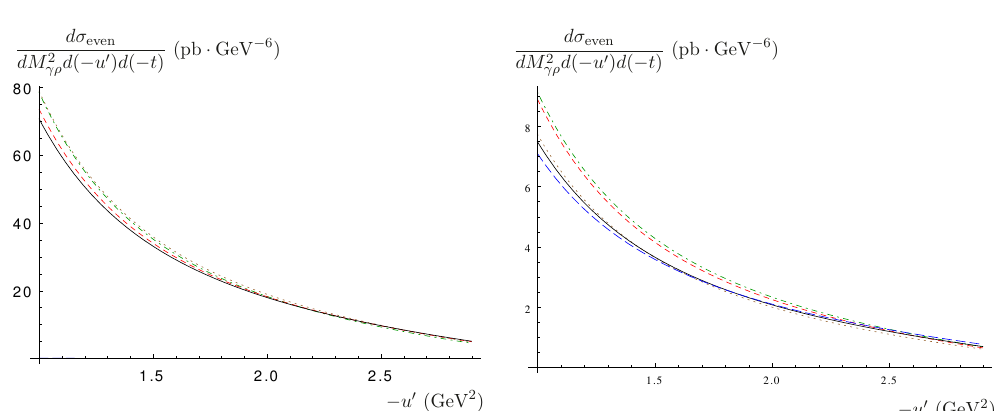
= 4 GeV 2 . The various γρ